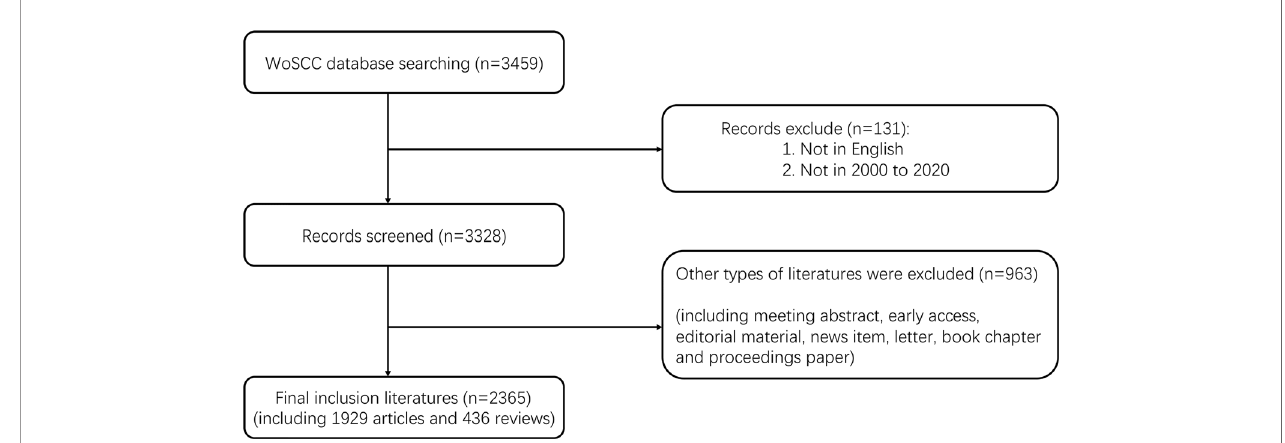
FIGURE 1 | Flowchart of data fi ltration processing and excluding